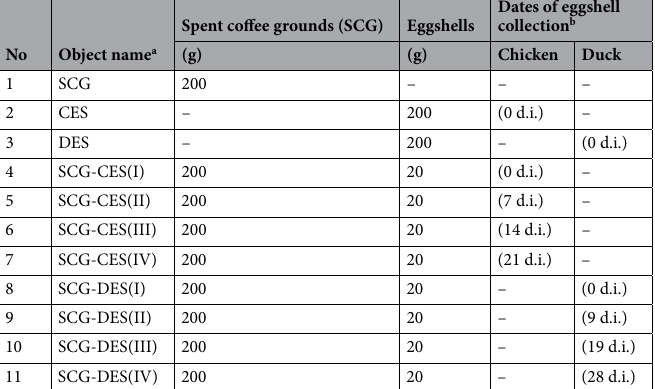
Table 2. Experimental design. a SCG spent coffee grounds, CES chicken eggshells, DES duck eggshells, I– IV dates of eggshell collection. b 0 days—prior to incubation, d.i.—day of embryo development (day of egg incubation in a